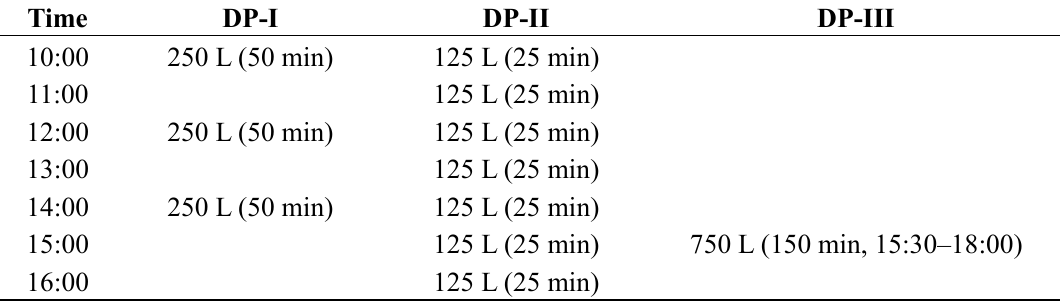
Table 2. Intermittent load conditions.